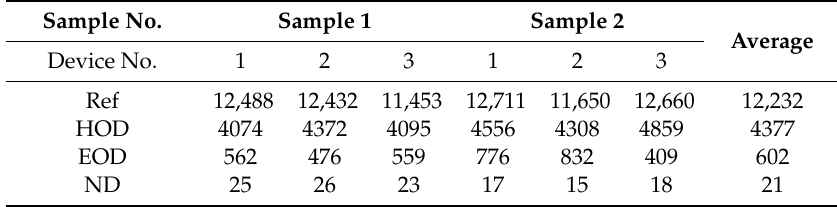
Table A3. The maximum luminance for each condition. (Measurement of six devices from two